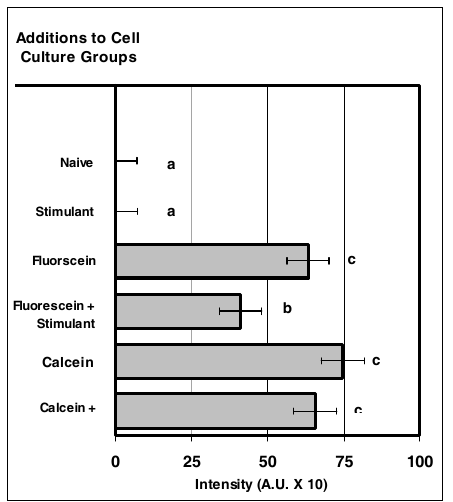
Figure 3: VIS micro-sensor dyes exhibit intracellular fluorescence after internalization by neutrophils. Neutrophil cultures were treated with either vehicle or VIS micro-sensor dyes (fluorescein or calcein; 20 µg/10 6 cells), and incubated for 24 hours. After this incubation period, the cultures were stimulated with LPS for 24 hours. After the 24-hour stimulation period, intracellular fluorescence of the VIS micro-sensor dyes was analyzed. Percent values are expressed as the mean + SEM, N = 8. Statistical significance (a), (b), and (c) were expressed as P < 0.05 in comparison to each other.